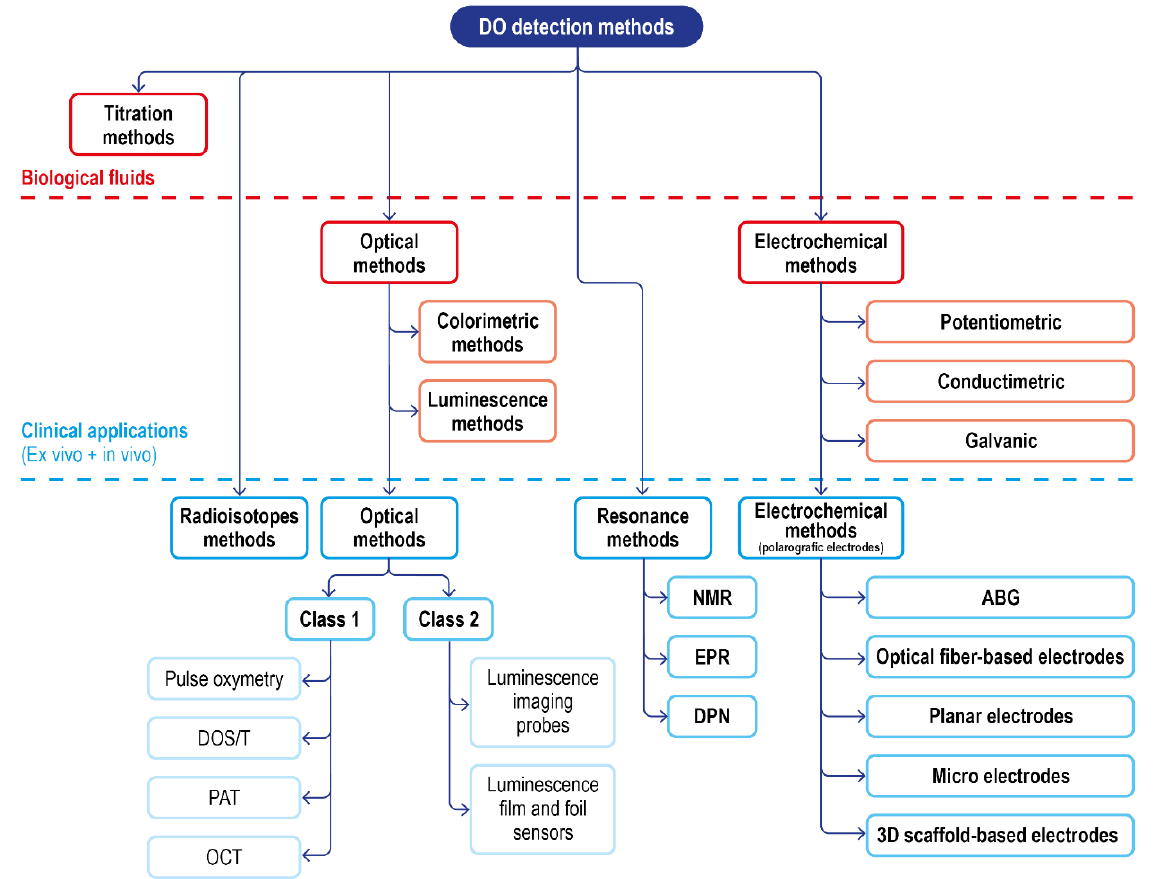
Figure 10. Schematic of the classical DO detection methods in biological fluids and of the advanced solution for clinical applications .